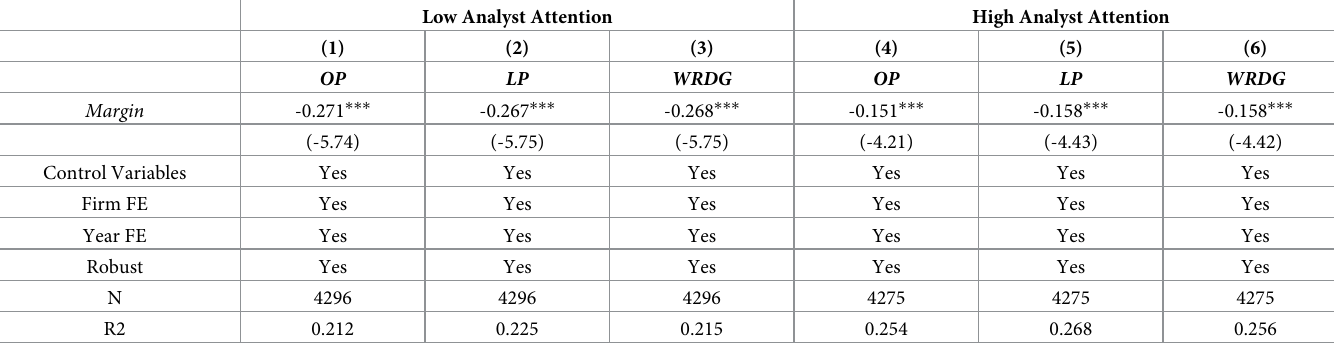
Table 10. Cross-sectional analysis by different levels of securities analyst attention.